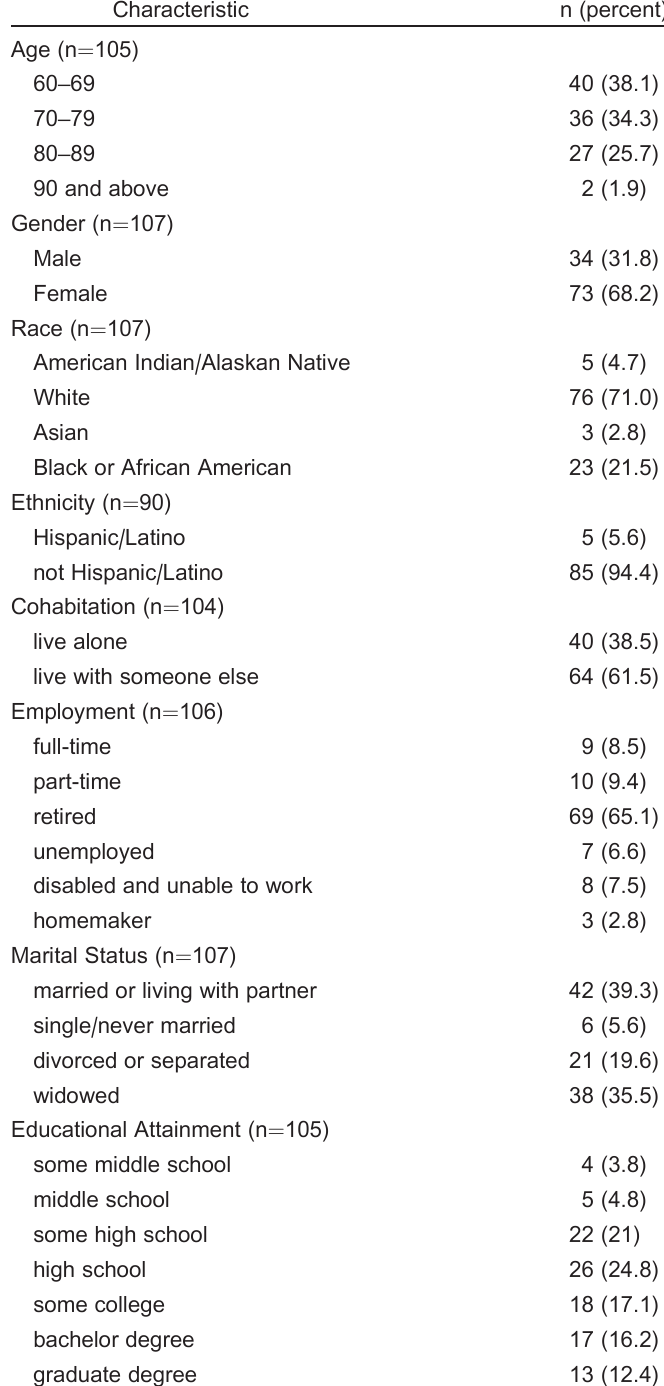
Table 1. Sociodemographic profile of study sample of older Americans to screen for prevalence of elder